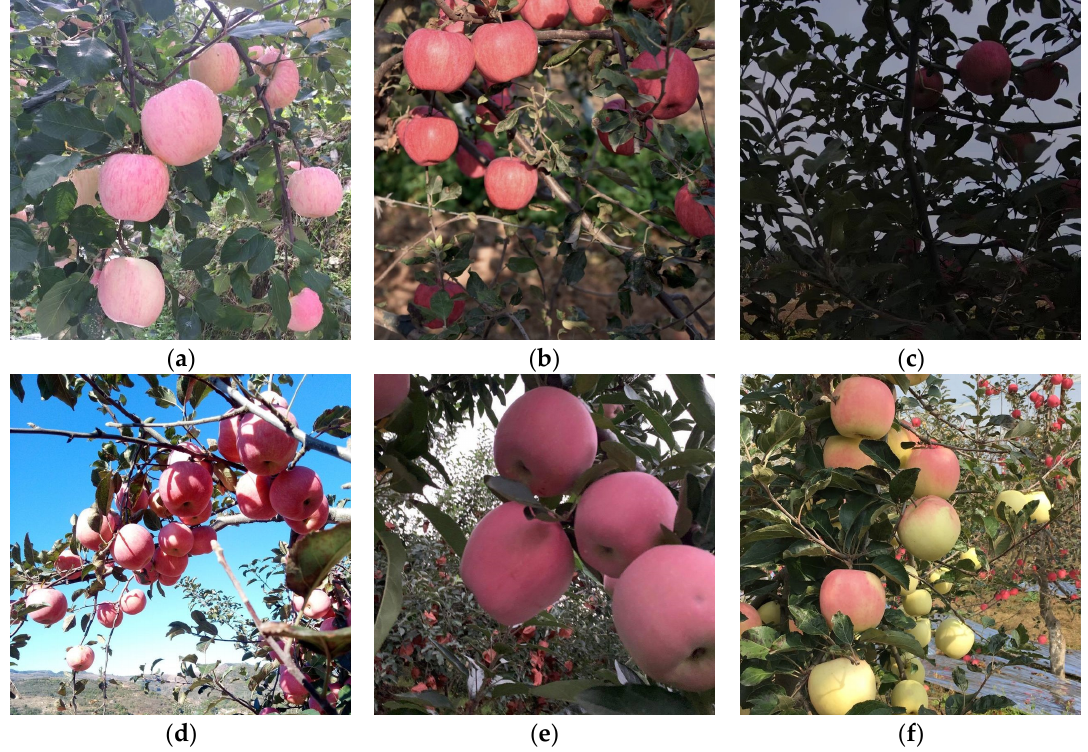
Figure 1. Images of apples in complex scenes: ( a ) Front light; ( b ) side light; ( c ) back light; ( d ) shaded; ( e ) unshaded; and ( f ) unripe.